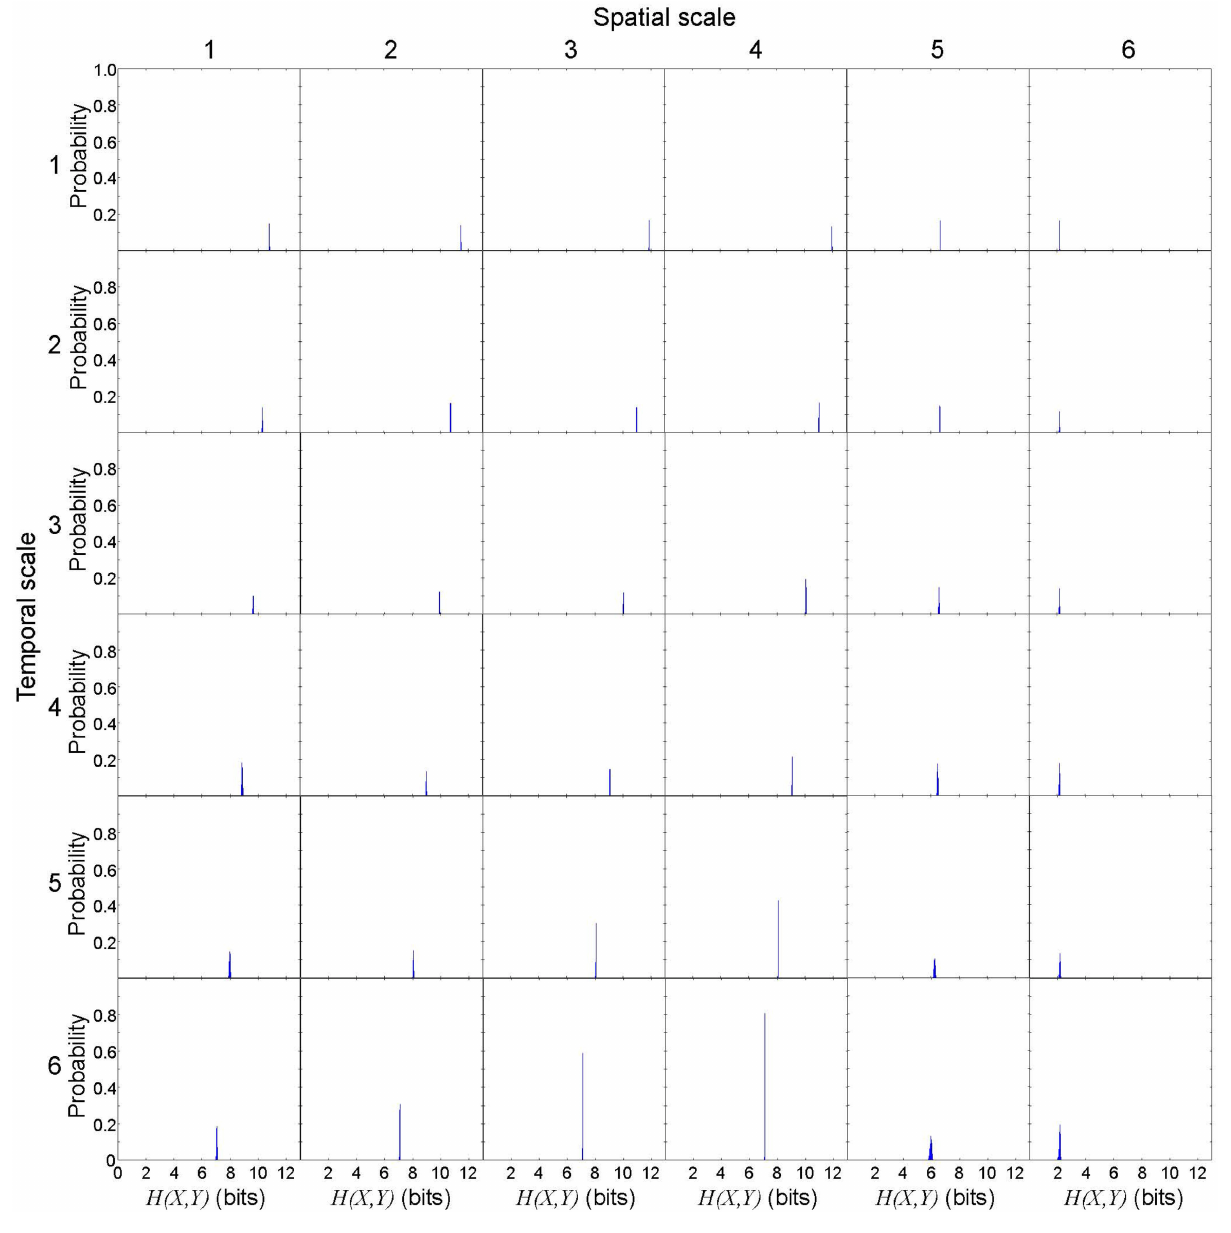
FIGURE 5 | Joint entropy of cause X and effect Y in a representative spiral wave data set. H ( X , Y ) is not uniquely determined due to the discretization effect, but the variance is small. Each subplot represents the probability distribution of H ( X , Y ). The columns represent the spatial scales (1 through 6) and the rows represent the temporal scales (1 through